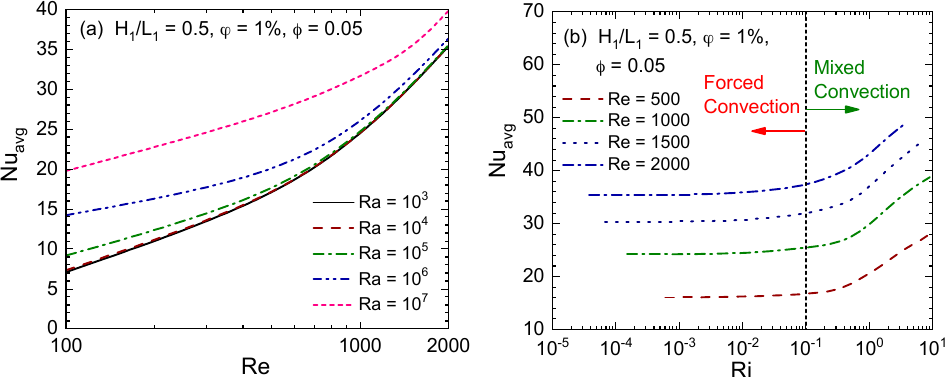
Figure 14. ( a ) Effect of Reynolds number on the average Nusselt number (Nu avg ) for various Rayleigh numbers and ( b ) effect of Richardson number on Nu avg for various Reynolds numbers. Different line types correspond to different Reynolds or Rayleigh numbers as indicated in the legend.